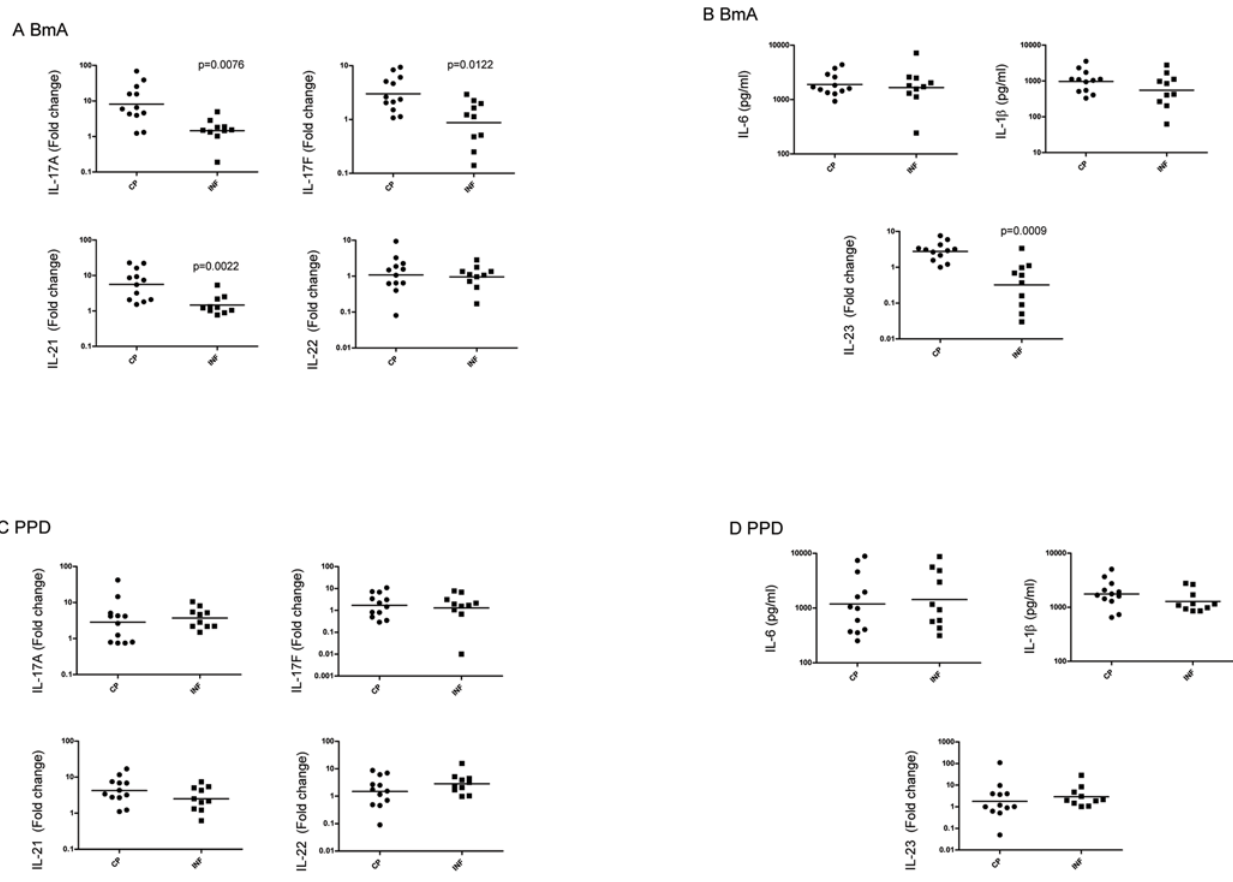
Figure 3. Filarial lymphedema is associated with enhanced expression of the IL-17 family of cytokines . PBMC expression of IL-17A, IL- 17F, IL-21 and IL-22 mRNA as measured by real-time RT-PCR following 24-hour stimulation with (A) BmA or (C) PPD and PBMC secretion of IL-6 and IL- 1 b as measured by ELISA and IL-23 mRNA as measured by real-time RT-PCR following 24-hour stimulation with (B) BmA or (D) PPD in filarial lymphedema [CP] (n=12) and asymptomatic infected [INF] (n=10) patients. Results are depicted as net cytokine production or as fold change over media control. P values were calculated using the Mann-Whitney test.